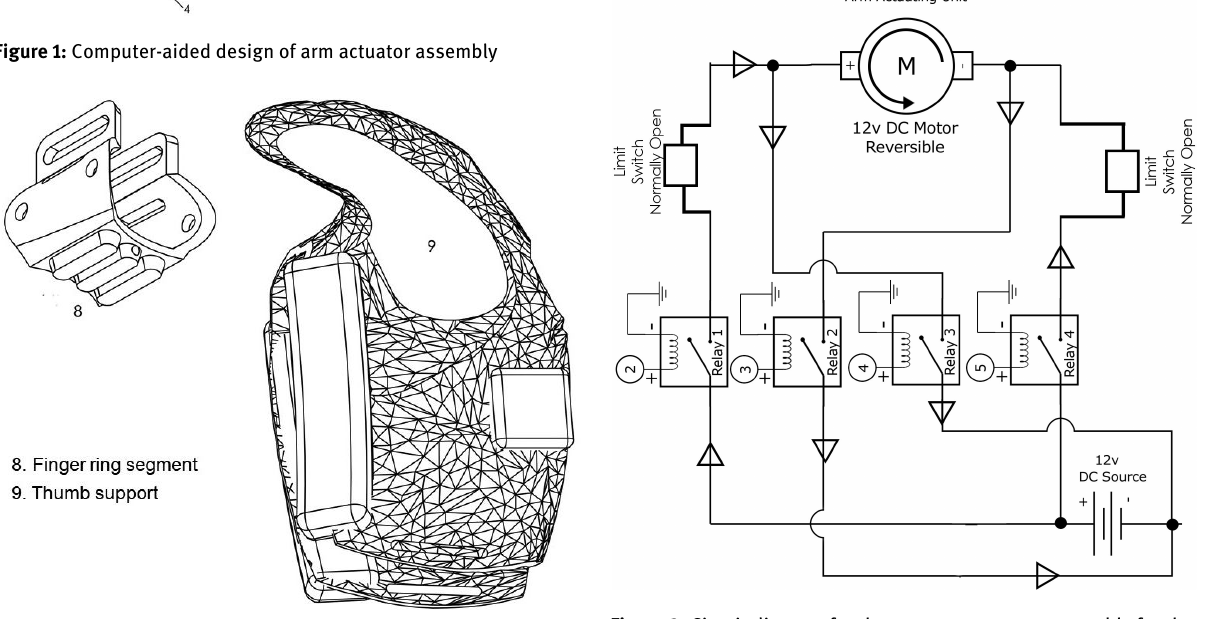
Figure 3: Circuit diagram for the motor-worm gear assembly for the arm lifting